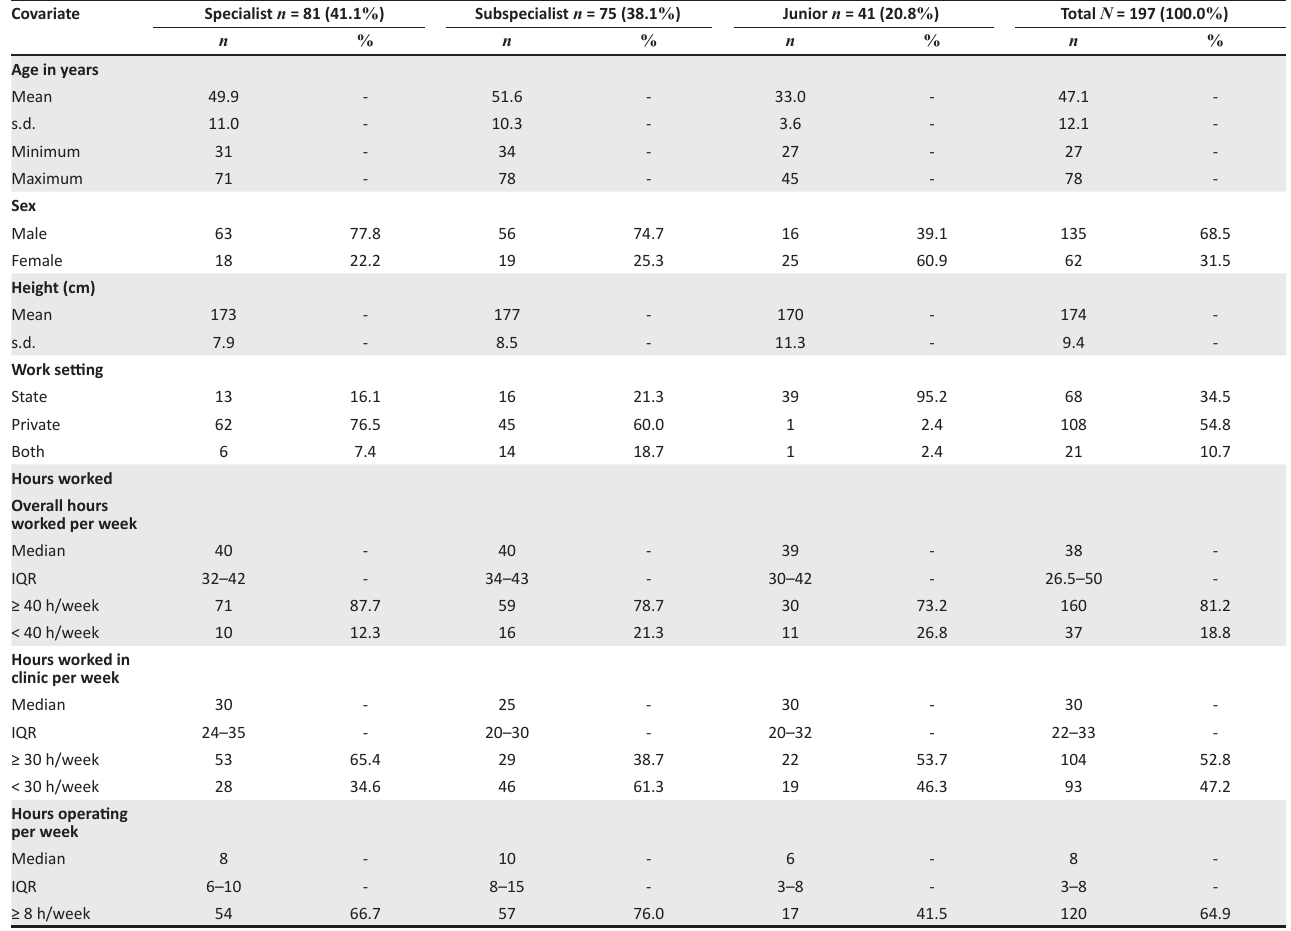
TABLE 1 : Demographics and occupational history of 197 doctors working in ophthalmology. Covariate Specialist n = 81 (41.1 % ) Subspecialist n = 75 (38.1 %